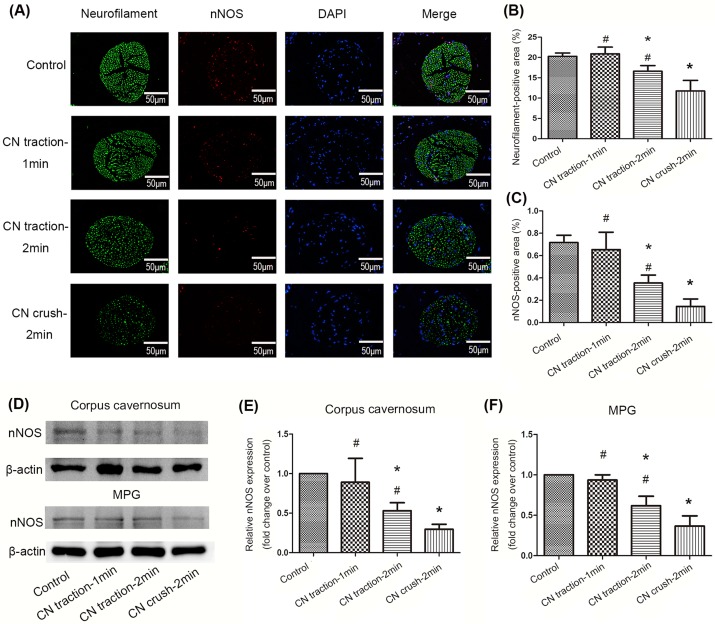
Changes of neuronal nitric oxide synthase(nNOS) and neurofilament content in the corpus cavernosum and MPG.(A) Neurofilament staining (green) and nNOS staining (red) in the dorsal penile nerve from different groups were performed with immunofluorescence. Nuclei were stained with DAPI (blue). Magnification: 400×. (B,C) Ratio of neurofilament positive area to the whole dorsal penile nerve area and nNOS positive area to the whole dorsal penile nerve area of four groups. Data are shown in the form of percentage. (D) Representative western blot bands for nNOS in the corpus cavernosum and MPG respectively. (E,F) Relative density of nNOS compared with β-actin in the corpus cavernosum and MPG. Data are shown as the fold changes over the control group. N = 6 in each group.* P<0.05 compared with control group. # P<0.05 compared with 2-min CN crush group.